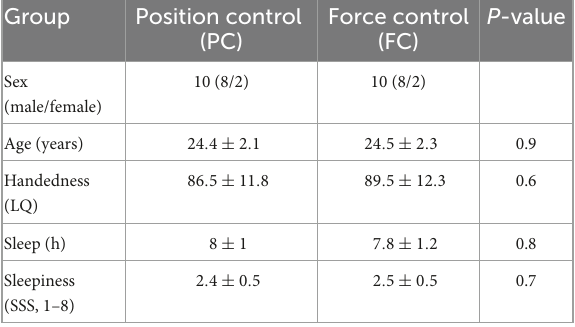
TABLE 2 Supplementary experiment: Characteristics of